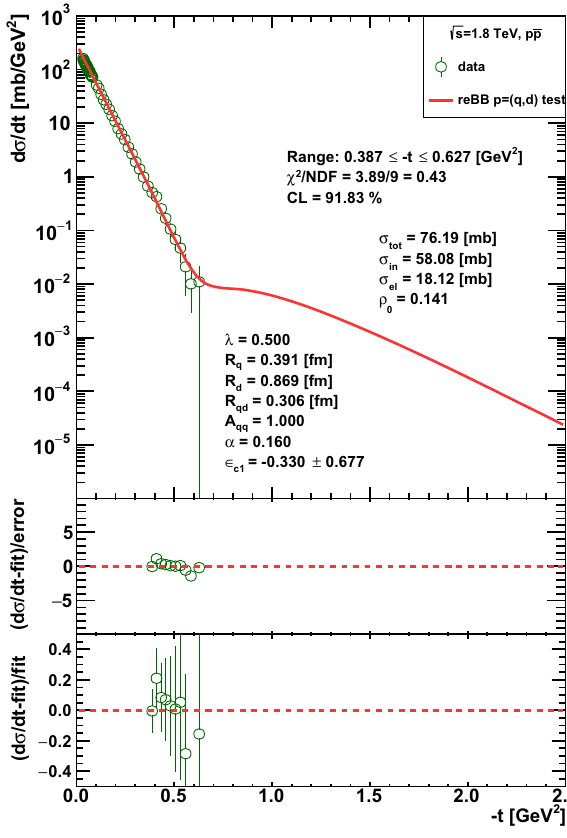
√ s = 0 . 63 Fig. 10 Result of a sanity test, same as Fig. 8, but for the 1.8 TeV p ¯ p elastic differential cross section data [67] in the range of 0 . 37 ≤ − t ≤ 0 . 6 GeV